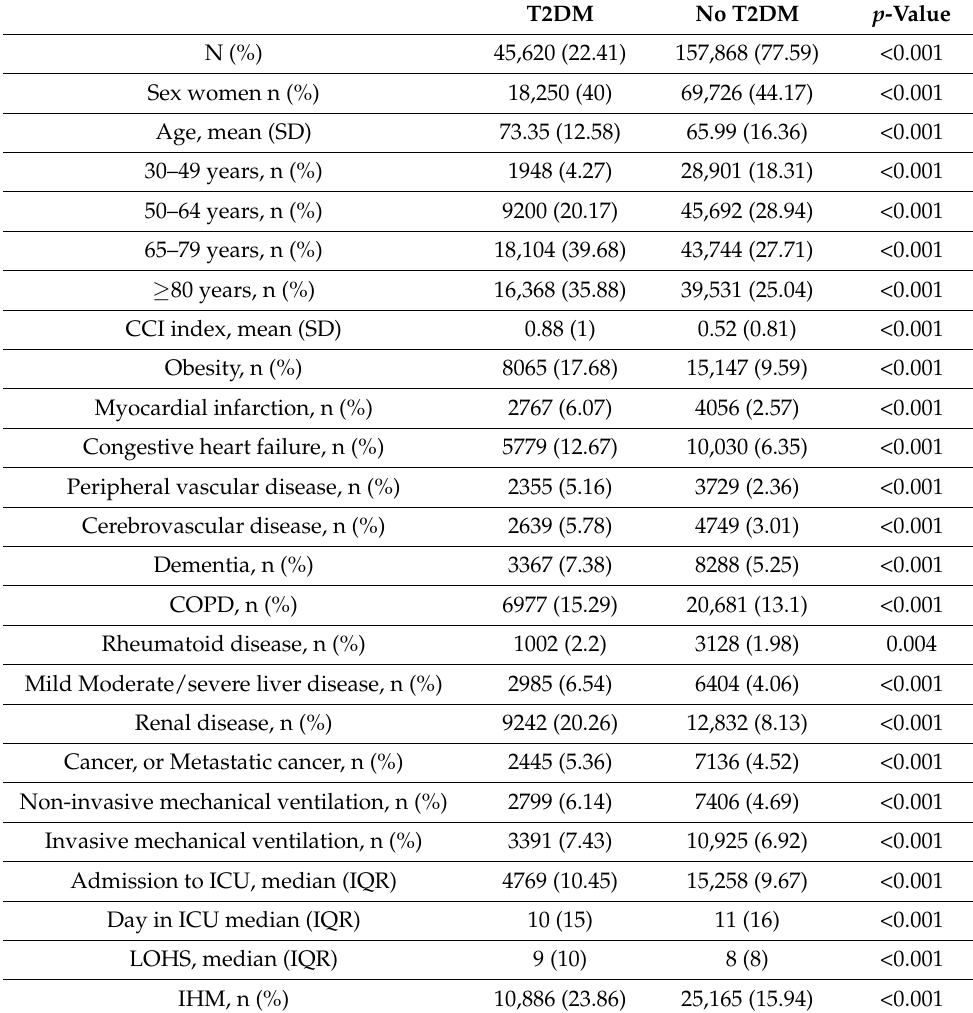
Table 1. Sociodemographic and clinical characteristics and in-hospital outcomes of patients hospital- ized with COVID-19 in Spain, 2020, according to diabetes